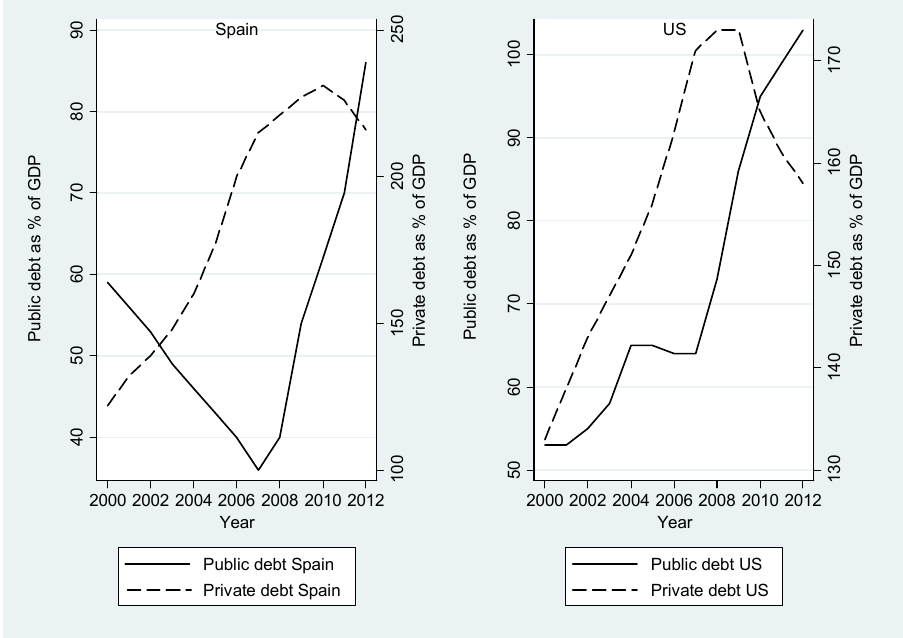
Figure 1 - Evolution of public and private debt: